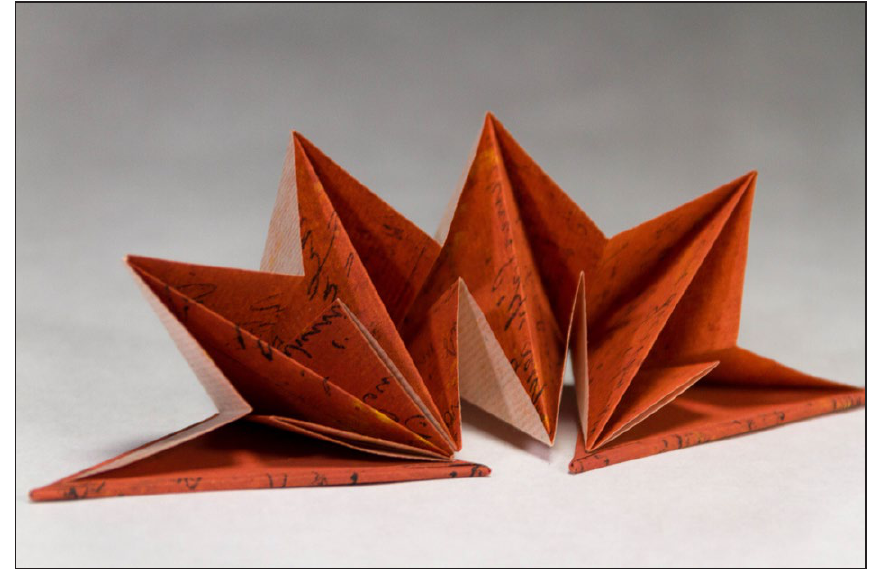
Figure 2: Rachel Epp Buller, I want to transcribe lullabies from every language, 2015, triangle book, approx. 2 × 3 inches